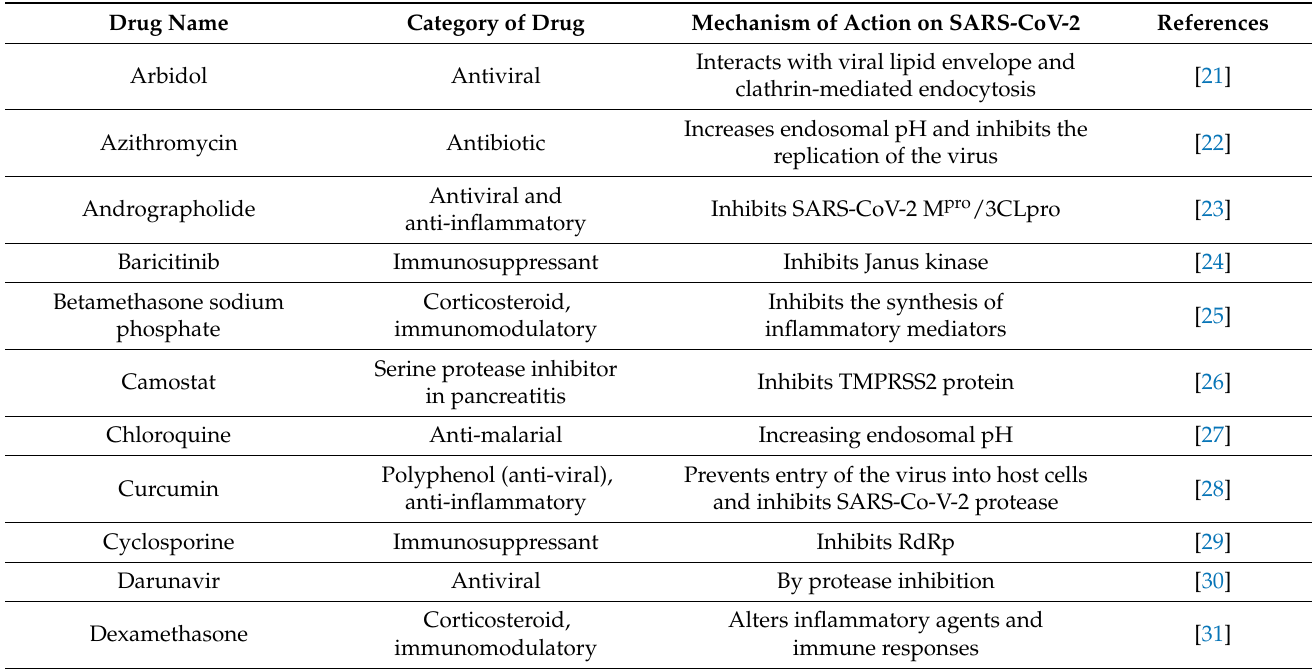
Table 1. List of ligands shortlisted for computational